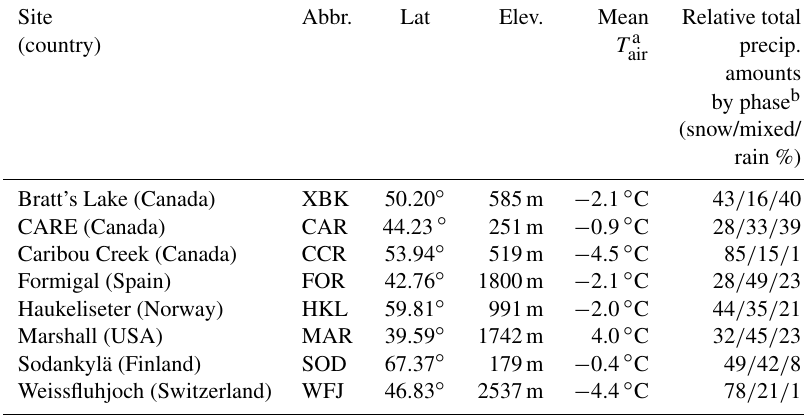
precip. air amounts by phase b (snow/mixed/ rain %)